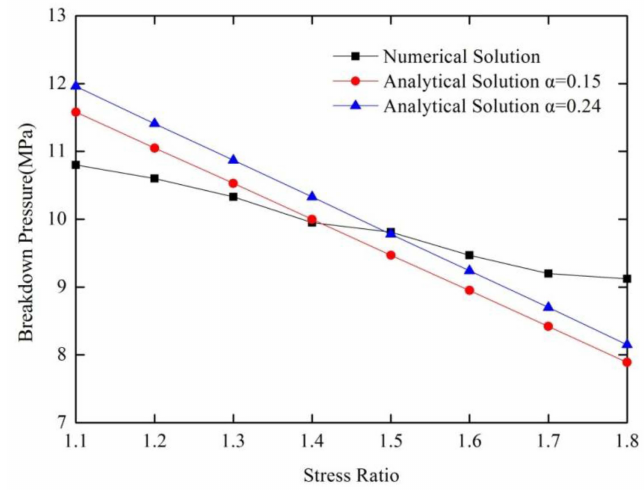
Figure 5. Comparison of breakdown pressure under different stress ratios between the analytical and numerical